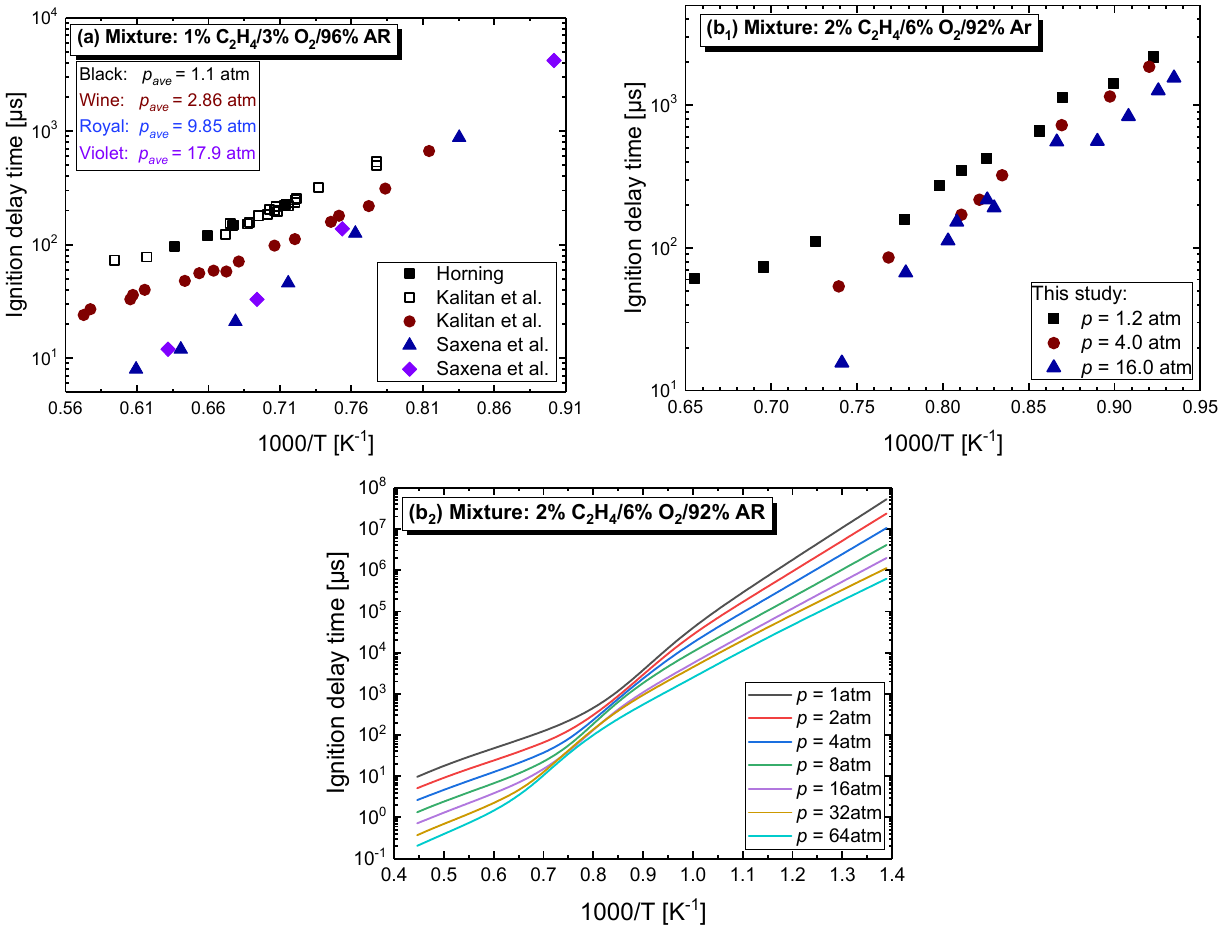
Figure 11. Non-linear pressure dependence of ethylene IDTs. ( a ) data from Horning [15], Kalitan et al. [17], Saxena et al. [21]; ( b1 ) data from this study; ( b2 ) simulations with NUIGMech 1.1.